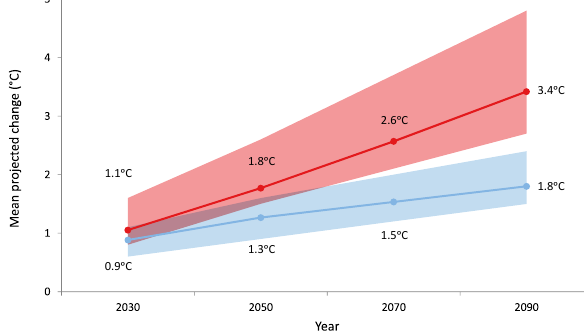
Figure 3. Predicted changes in average annual rainfall in the Ade- laide Mt. Lofty Ranges region (from Goyder Institute for Water Re- search, 2015).